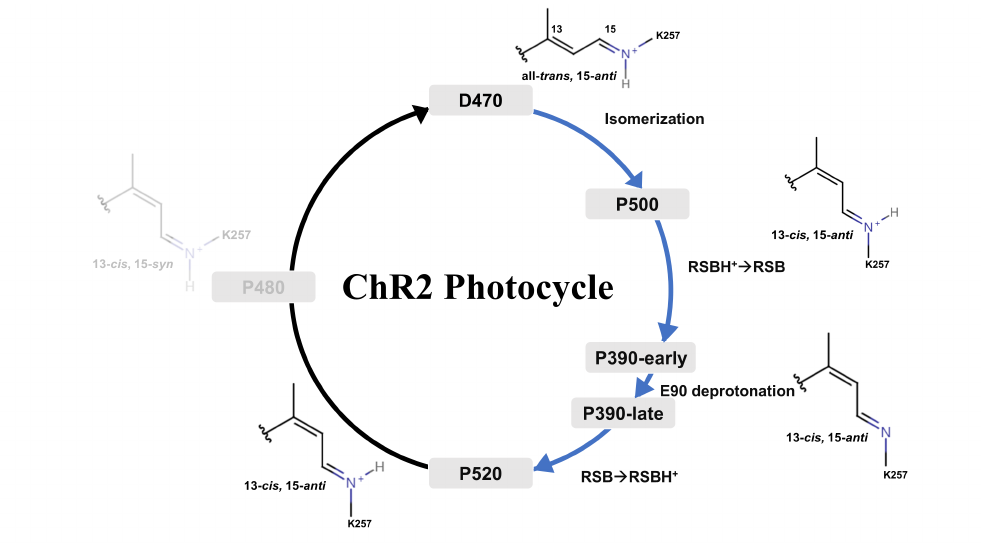
Figure 1. Schematic diagram of the photocycle of ChR2, and corresponding structural changes of retinal in the intermediate states during the photocycle. In the D470 state, retinal is in an all- trans conformation, and retinal is then isomerized to the 13- cis conformation by photoactivation to form the P500 state. The proton on the Schiff base is transferred to E123 or D253 to form the P390-early state. Subsequently, deprotonation of E90 leads to the formation of the P390-late state. Finally, the Schiff base is reprotonated to form the P520